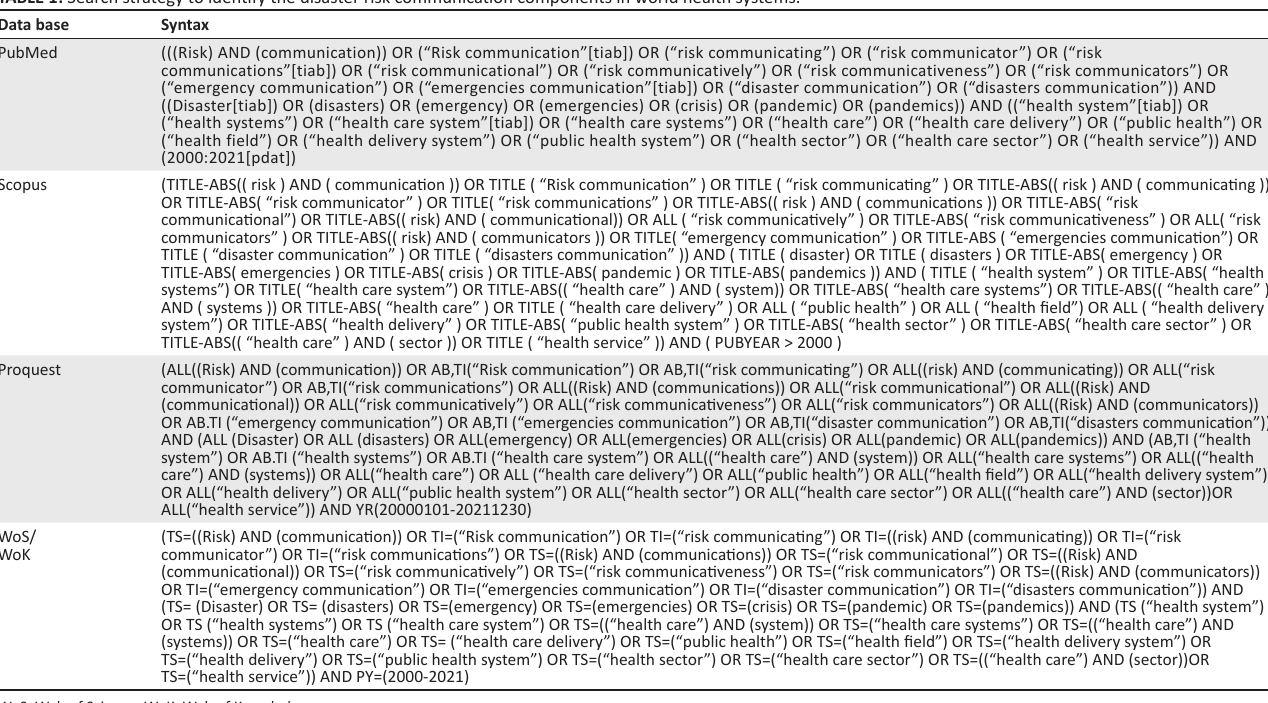
TABLE 1: Search strategy to identify the disaster risk communication components in world health